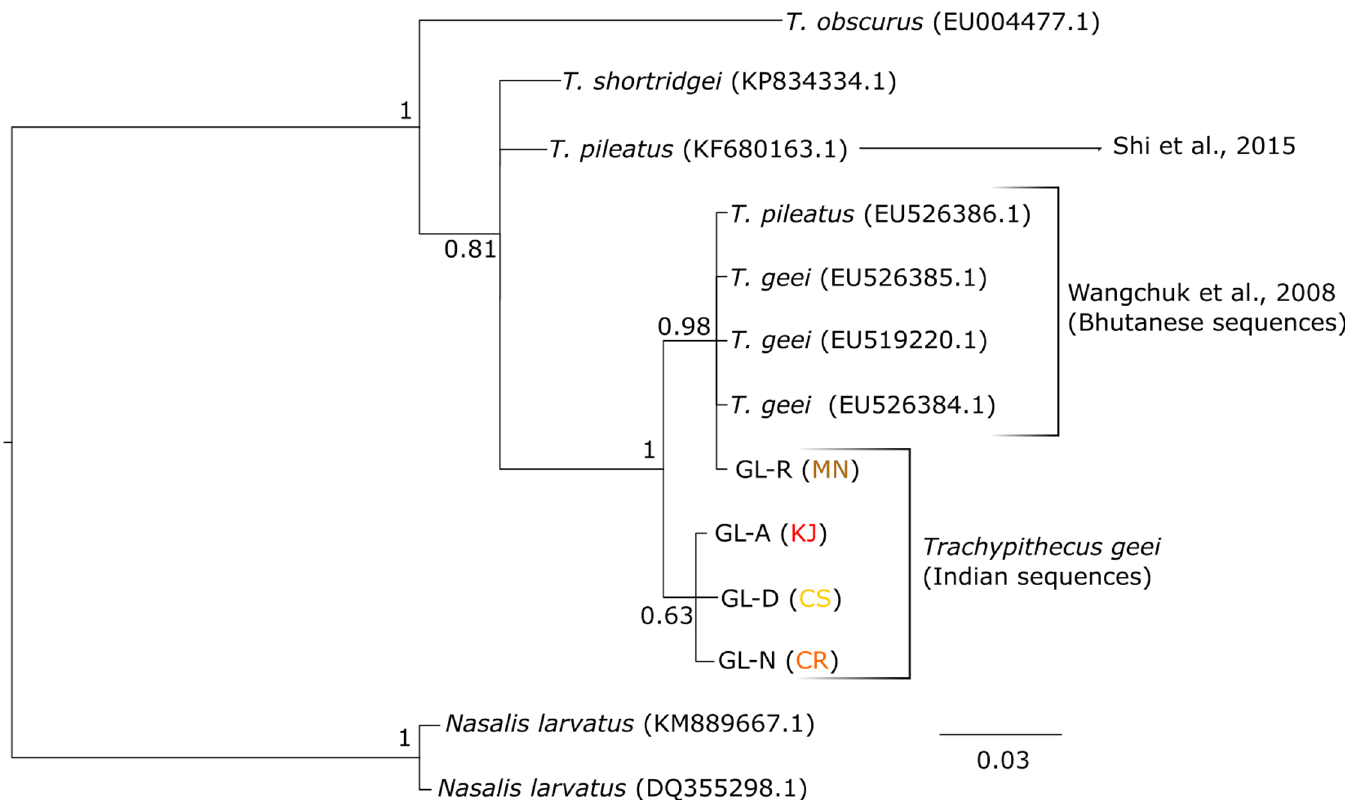
Fig 4. Bayesian Inference tree of cytochrome b. Bayesian inference tree reconstructed from 392 bases of cytb. Leaves are labelled with the species and accession codes in parentheses and, for golden langurs, haplotype codes. The numbers at each node are the Bayesian posterior probability values. Sequences generated in the present study and by other authors have been